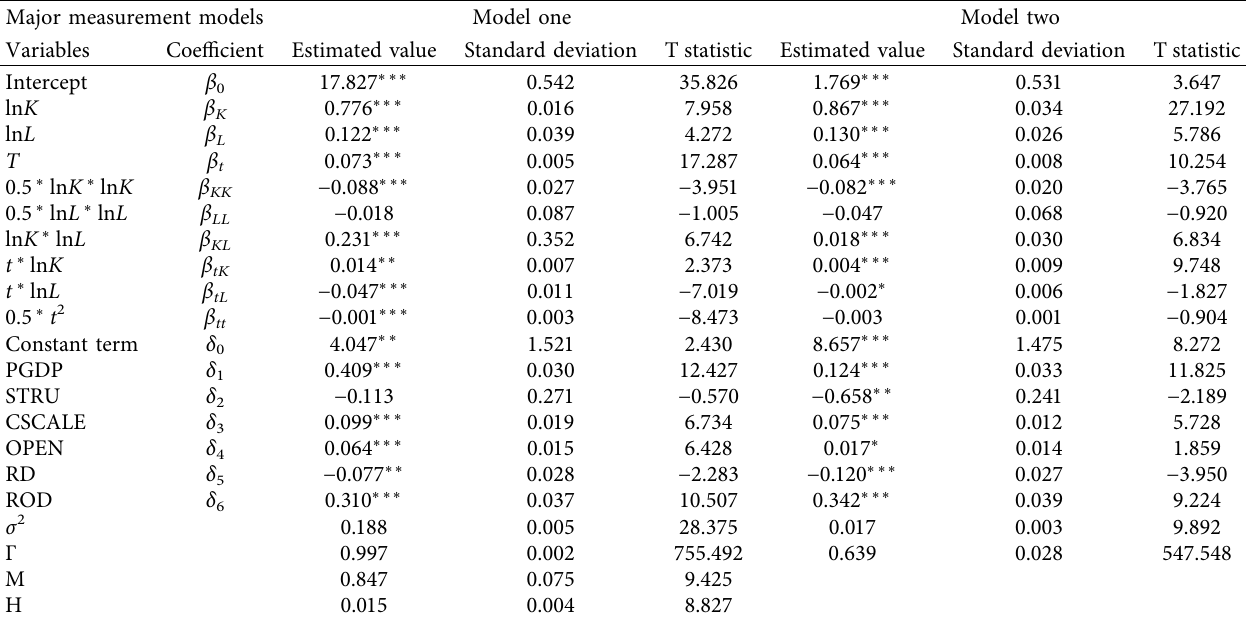
Table 2: Estimation result of stochastic frontier production model.